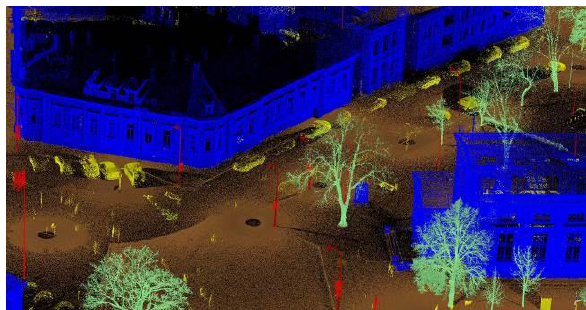
Figure 1. Output from HALILAMA project: classified point cloud